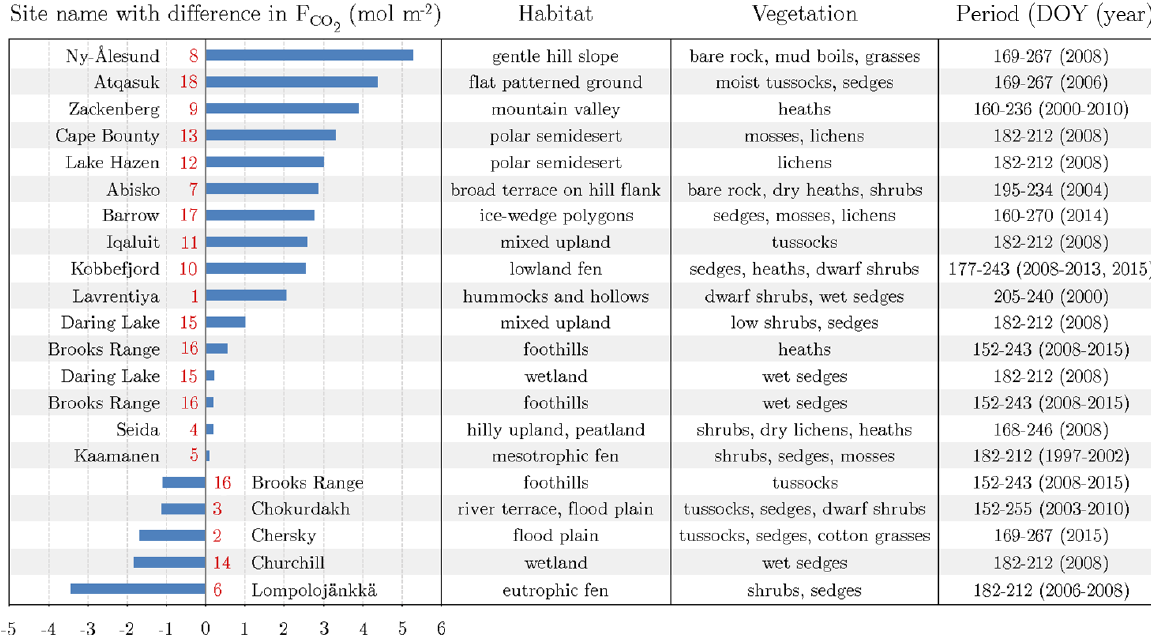
Table 3. Putting the carbon dioxide budgets of the flood plain in perspective with budgets estimated by means of the eddy covariance method at other Arctic sites. A negative/positive difference in the budgets indicates a carbon dioxide sink strength of the comparison site being greater/lower than the one of the flood plain on Samoylov Island. For an appropriate comparison, the budgets of this study’s site were recomputed for the day of the year (DOY) periods of the other sites. In this process, representative 2015 flux data were basically utilised, unless the budget of the other site derived from 2014. If the budget period of the other site exceeded the period of this study’s budget, the (few) missing days in the start/end were filled with the daily sum of the first/last day in the budget period. The numbers next to the bars refer to the numbers in the circumpolar map (Fig. 1). Compared to various Arctic sites, the flood plain on Samoylov Island constitutes a distinctly strong carbon dioxide